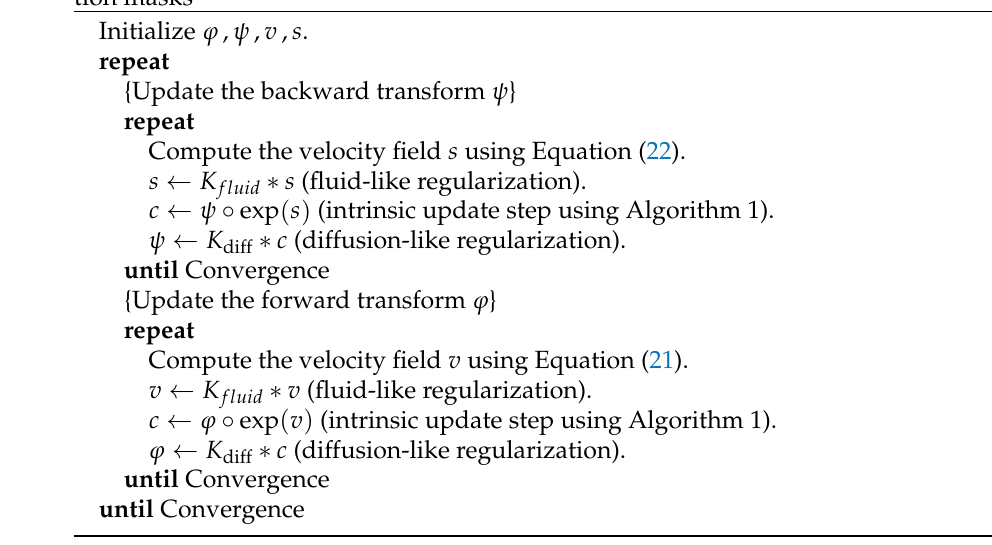
Algorithm 2 Symmetric diffeomorphic image registration with multi-label segmenta- tion